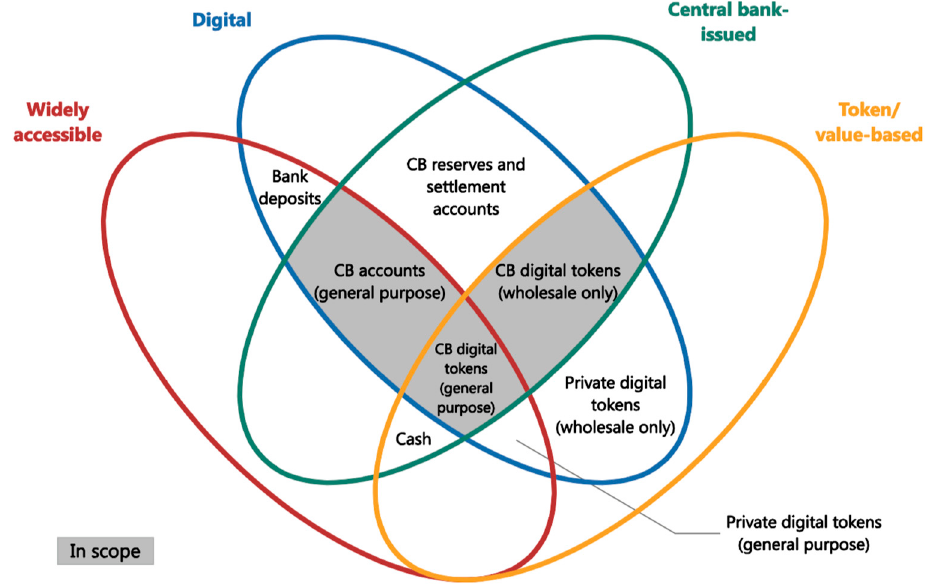
Figure 1. The money flower: a taxonomy of money; source: [43,51].